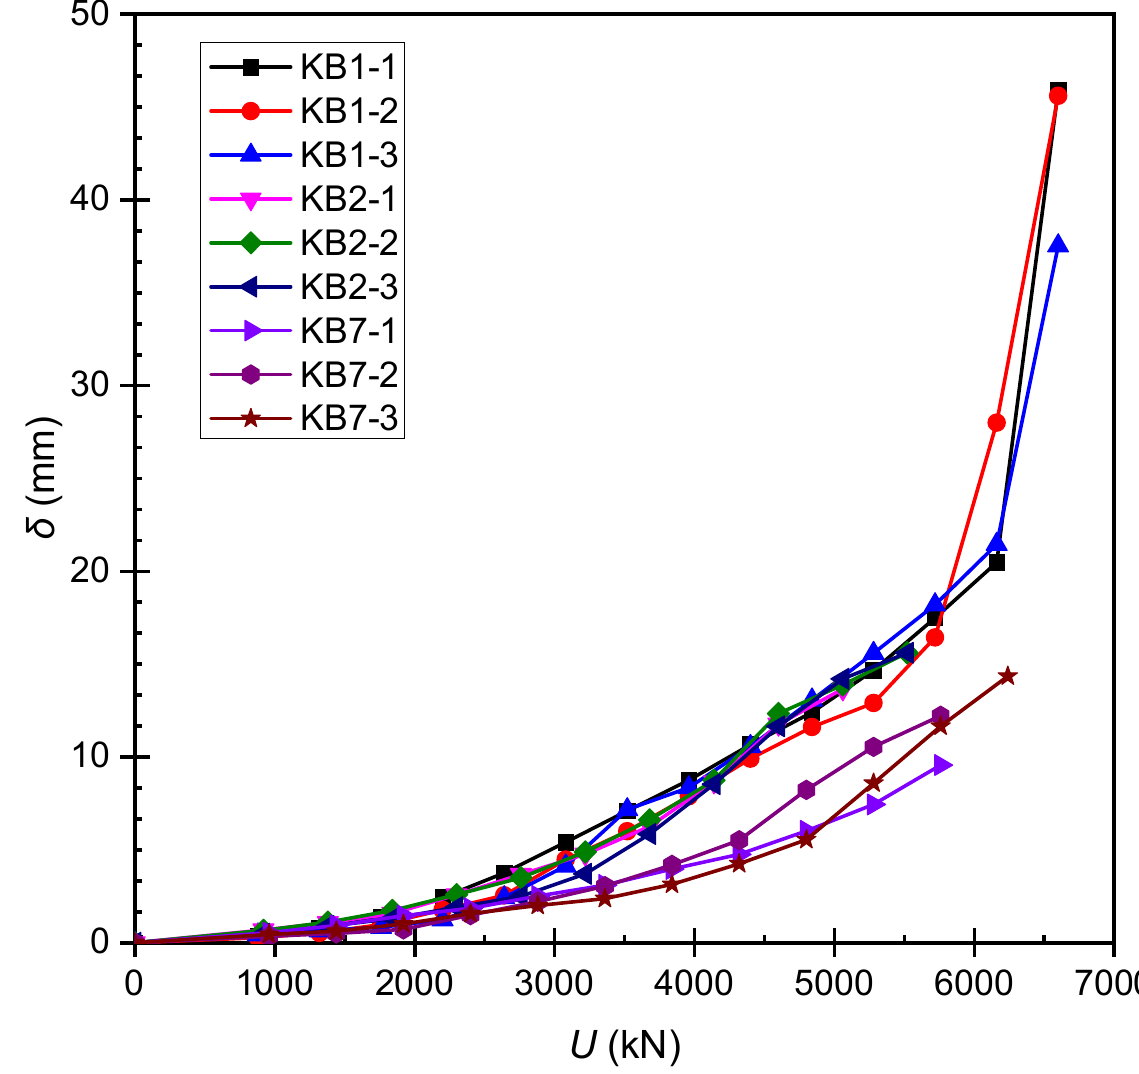
Figure 4. Experimental curves of U ‐ δ for test piles.